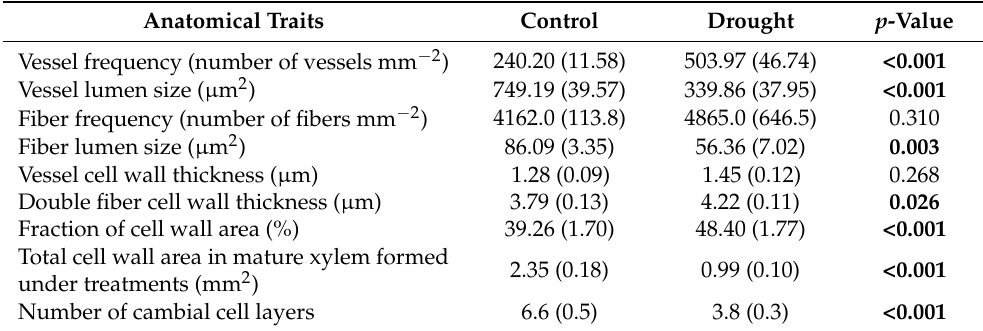
Table 3. Anatomical characteristics of poplar (hybrid T89) in response to severe drought treatment. Data show means (SE) of n = 5. One-way ANOVA was conducted to compare the differences among treatments. p -values for mean that differ at p < 0.05 are indicated by fat